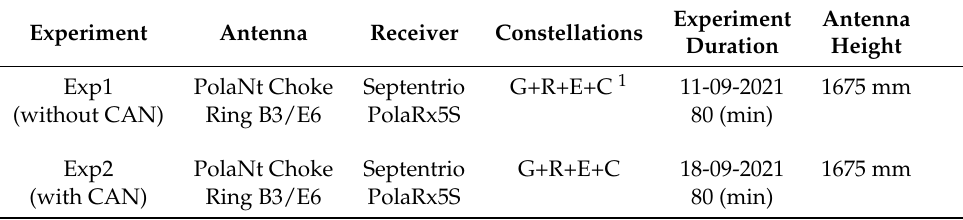
Table 2. Equipment, duration, constellations and the antenna height for the two experiments. Experiment